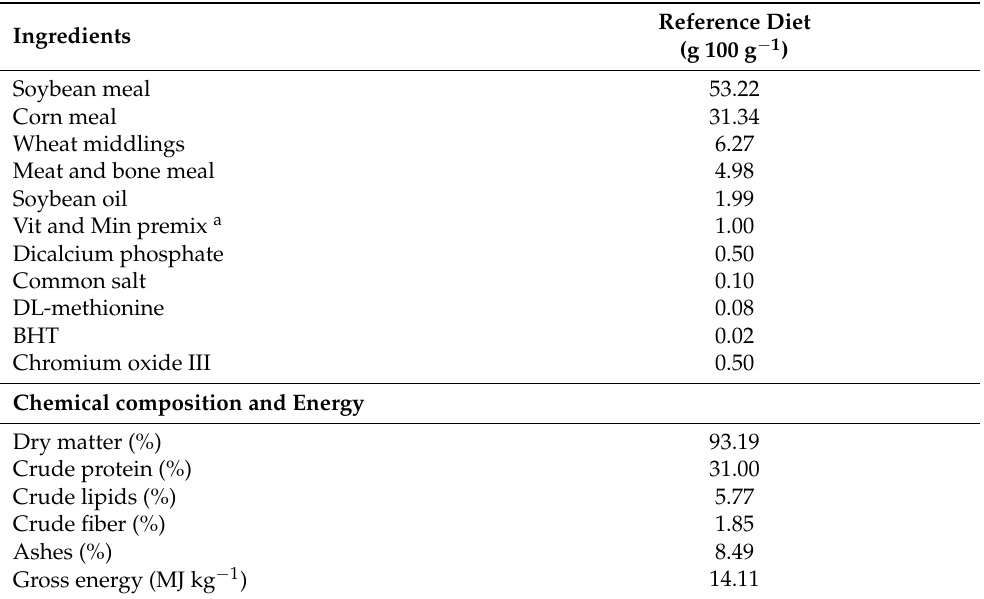
Table 1. Formulation and chemical composition of the reference diet utilized in the digestibility assay (values expressed on dry matter